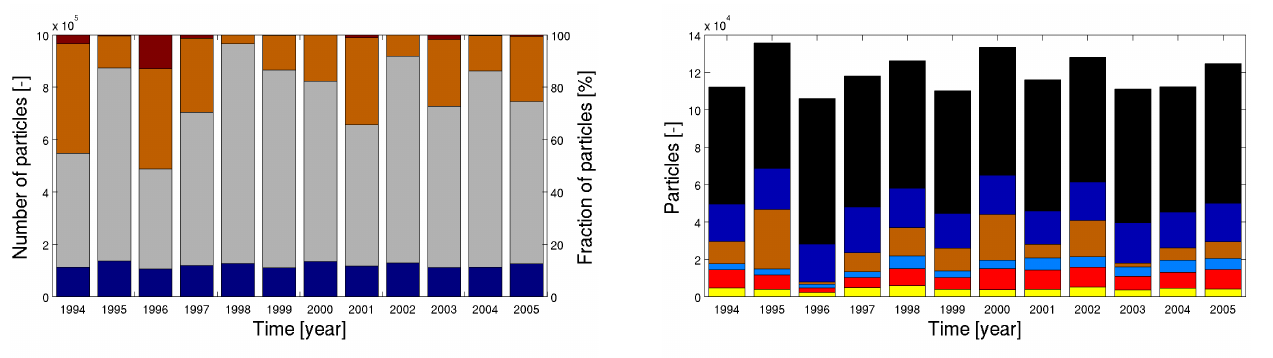
Figure 12. Final status of all particles for each year: (blue) parti- cles that settle; (grey) particles that do not settle; (orange) particles that do not settle but also do not reach end of the 30-day settle- ment stage before the numerical simulation is truncated after 120 days; (red) particles that do not settle as these have not yet reached the beginning of their 30-day settlement stage, before simulation is truncated.